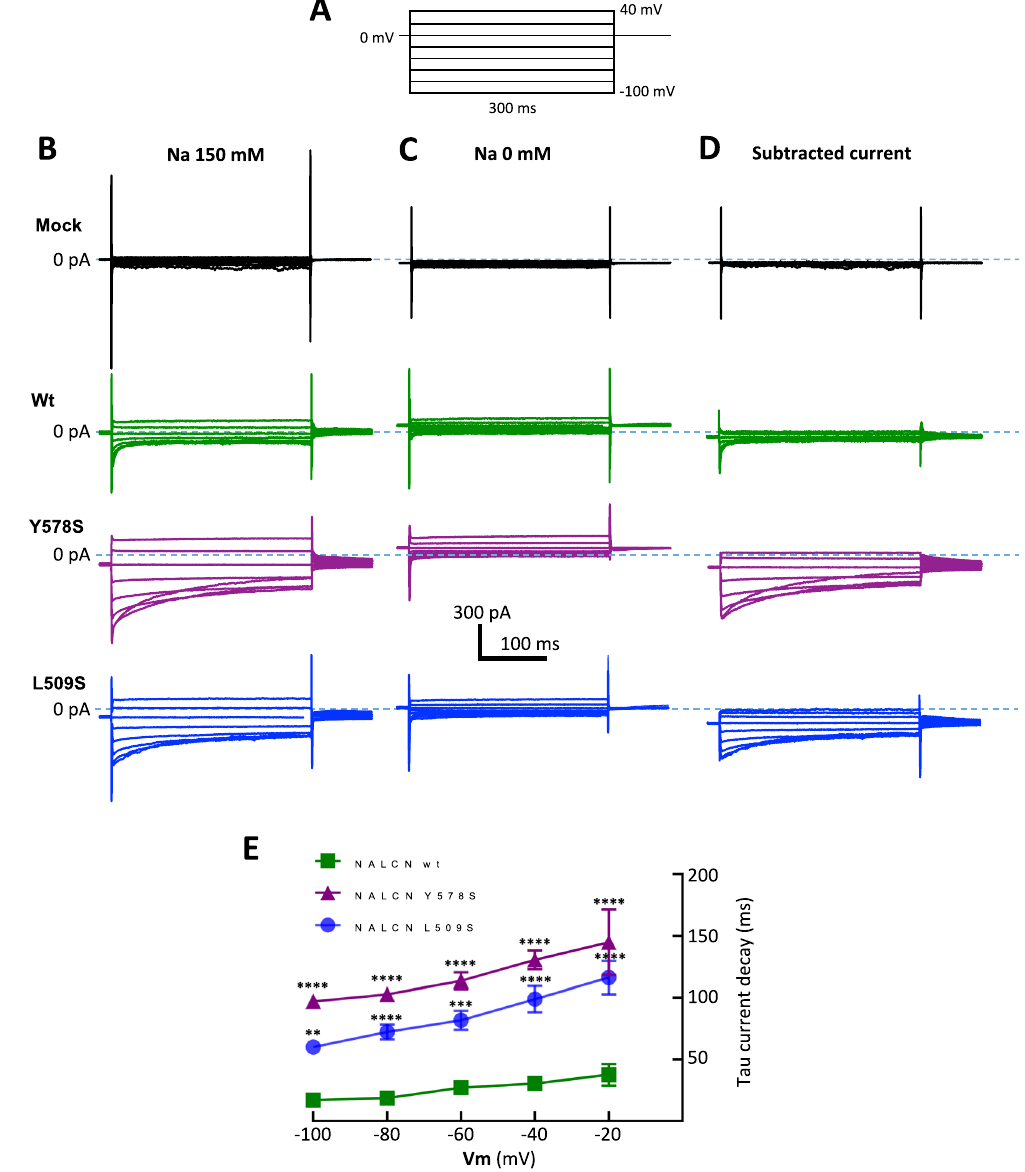
Figure 5. Time- and voltage-dependent inactivation of the NALCN current elicited by the wt, Y578S and L509S variants. ( A ) Voltage step protocol used to elicit representative current traces obtained in the presence of extracellular Na + ( B ), in the absence of extracellular Na + ( C ) and the corresponding trace subtraction to isolate the Na + -dependent component of the NALCN current ( D ) for mock-transfected cells (black traces), NALCN- wt-transfected cells (green traces), NALCN-Y578S-transfected cells (purple traces) and NALCN-L509S- transfected cells (blue traces). ( E ) Inactivation kinetics (time-constant, τ ) of the Na + -dependent component of the wt (n = 7), NALCN-Y578S (n = 7) and NALCN-L509S (n = 6) currents in the − 100 mV to − 20 mV range. Statistical significance was calculated with a Tukey’s multiple comparisons